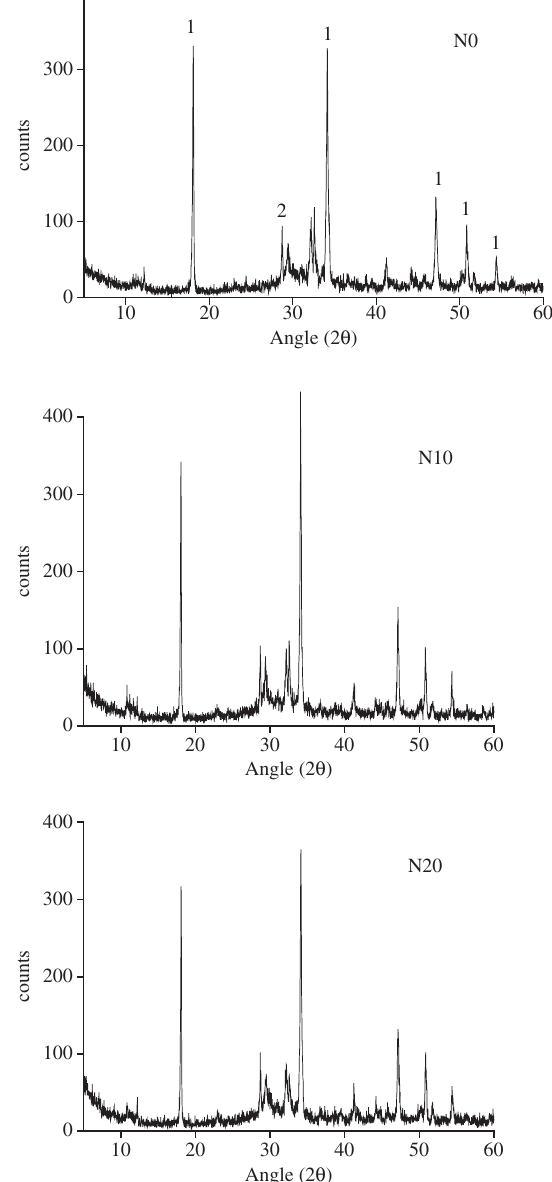
Figure 4. XRD of N0, N10 and N20 at 7 hydration days.